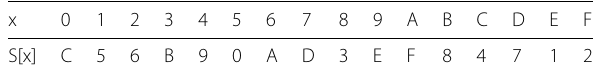
i.e., [ k 79 k 78 . . . k 1 , k 0 ] = [ k 18 k 17 . . . k 20 k 19 ]; (2) the